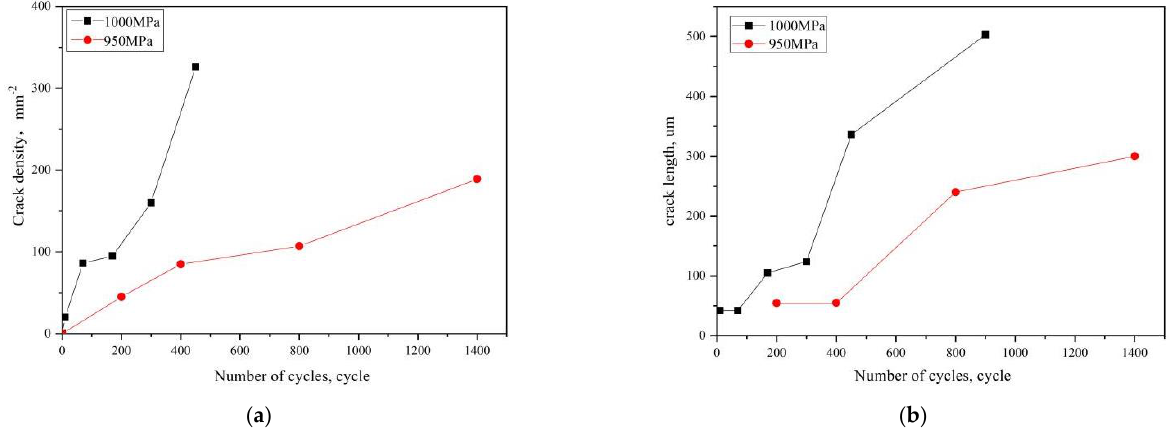
Figure 8 . Statistics early fatigue cracks under different stress amplitudes. ( a ) Crack density. ( b ) Maximum crack length.